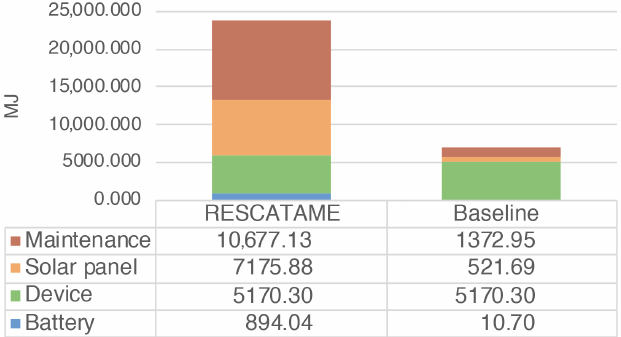
Figure 7. Energy impact of RESCATAME project and baseline green solution.